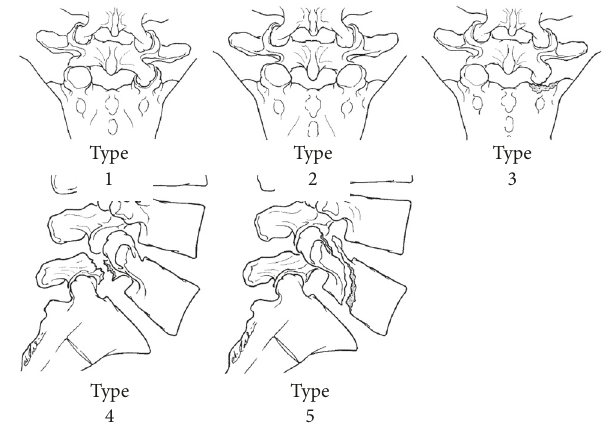
Figure 1: Classification of fracture-dislocation of the fifth lumbar vertebra according to Aihara et al.